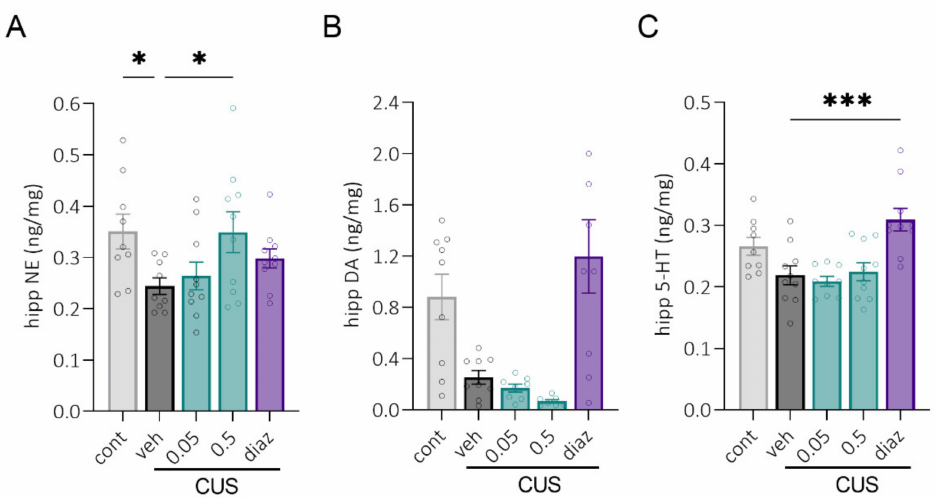
Figure 6. Chronic LCGA-17 effects on the bioamines levels after CUS. Separate groups were treated for 22 days before sacrifice with either LCGA-17 (0.05 and 0.5 mg/kg i.n.) or diazepam (0.5 mg/kg i.p.). ( A ) The norepinephrine level was significantly reduced in the hipp of stressed rats compared to the control animals. LCGA-17 in a dose of 0.5 mg/kg increased the NE levels in the hippocampus to the control levels (F (4, 40) = 2.79, p = 0.038; ANOVA, Dunnett’s test); ( B ) None of the treatments showed a significant change in hipp DA concentrations (H (5, 42) = 21.97, p = 0.0002; K–W, Dunn’s test); ( C ) Diaz increased the 5-HT levels in the hipp of stressed rats (F (4, 40) = 8.1, p < 0.0001; ANOVA, Dunnett’s test). * p < 0.05 and *** p < 0.001 vs. the veh